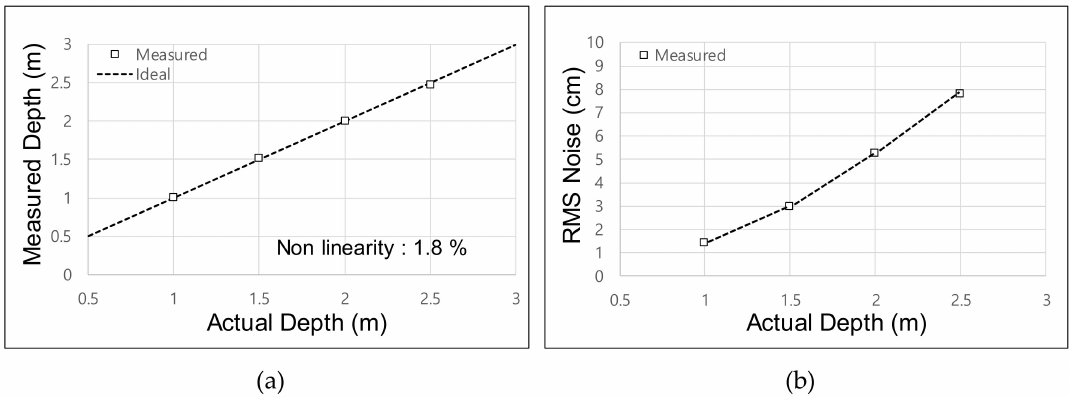
Figure 9. Measured depth from the fabricated sensor chip: ( a ) measured depth; ( b ) root-mean-square (RMS)